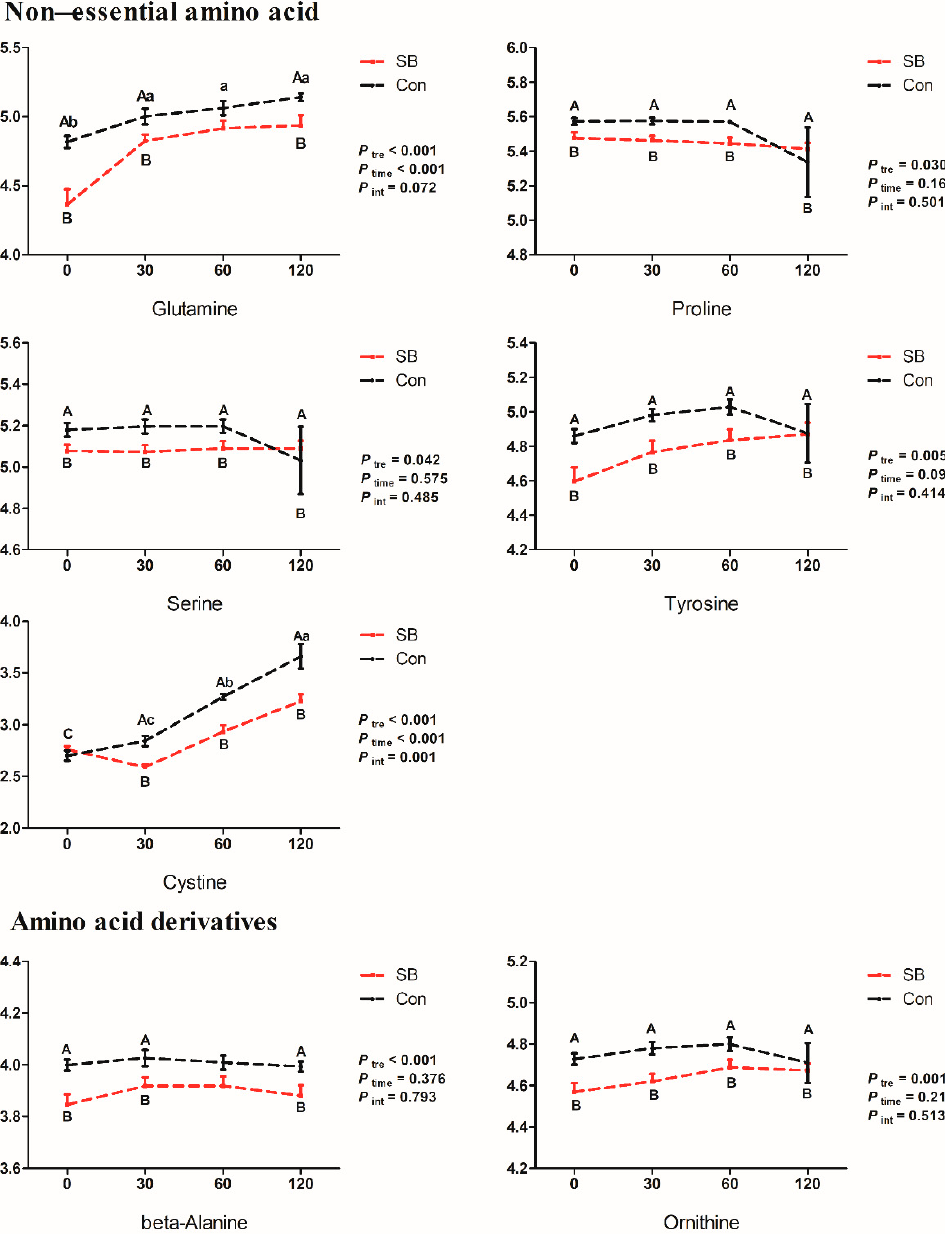
Figure 7. Dynamic changes of the relative concentrations of non-essential amino acids and derivatives. X-axis presents the relative concentrates of corresponding metabolites with Log processing of the peak area. Di ff erences were analyzed by two-way ANOVA using PROC MIXED with time and SB treatment as the main factors followed by post-hoc analysis in SAS. Ptre, Ptime, Pint represents the significances of SB treatment, time, and interaction e ff ects, respectively. Superscript with A or B means significant di ff erence between control group (Con) and sodium butyrate group (SB). Superscript with a, b, and c means significant di ff erence over time.